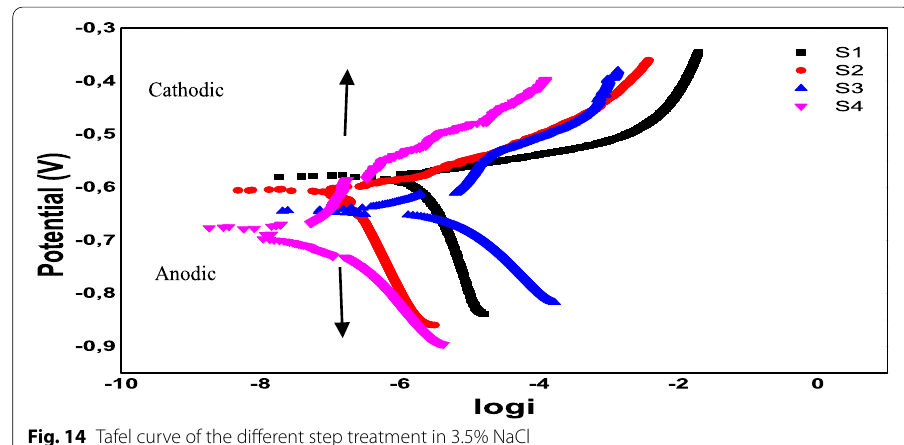
Fig. 14 Tafel curve of the different step treatment in 3.5% NaCl